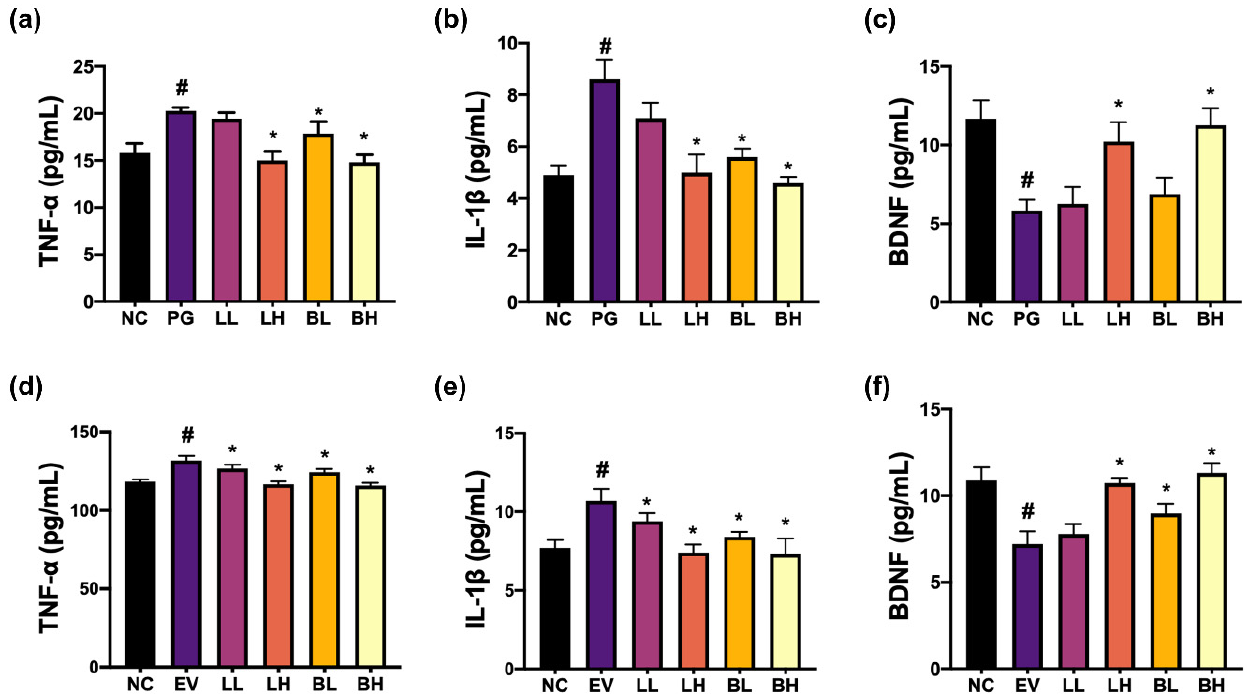
Figure 1. NK357 and NK391 decreased TNF- α and IL-1 β expression in PG- or pEVs-stimulated BV2 cells and increased BDNF expression in PG- or pEVs-stimulated SH-SY5Y cells. Effects on PG-induced TNF- α ( a ) and IL-1 β expression ( b ) in BV2 cells. ( c ) Effects on PG-suppressed BDNF expression in SH-5Y cells. Effects on pEVs-induced TNF- α ( d ) and IL-1 β expression ( e ) in BV2 cells. ( f ) Effects on pEVs-suppressed BDNF expression in SH-SY5Y cells. ( a – c ): NC, treated with vehicle; PG, treated with 1 × 10 5 CFU/mL of PG; LL, 1 × 10 4 CFU/mL of NK357 with PG; LH, 1 × 10 6 CFU/mL of NK357 with PG. ( d – f ): EV, treated with 50 ng/mL of pEVs; LL, 1 × 10 4 CFU/mL of NK357 with EV; LH, 1 × 10 6 CFU/mL of NK357 with EV; BL, 1 × 10 4 CFU/mL of NK391 with EV; BH, 1 × 10 6 CFU/mL of NK391 with EV. Data were described as mean ± SD ( n = 4). # p < 0.05 vs. NC. * p < 0.05 vs. PG or EV.